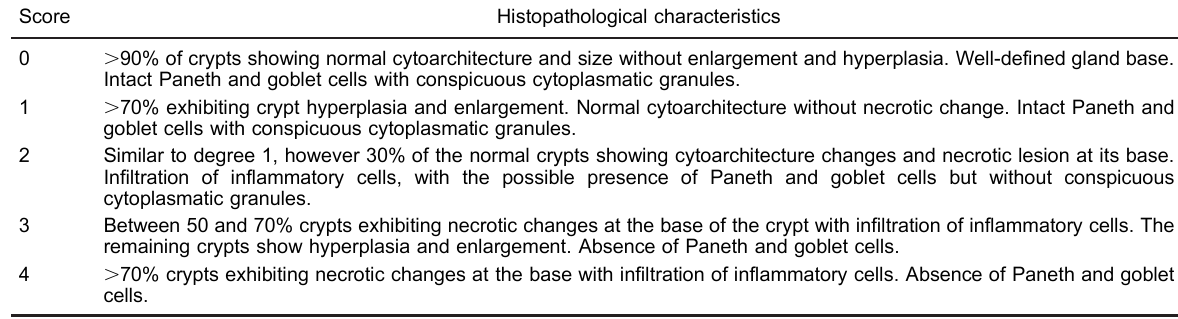
Table 1. Criteria used to determine intestinal crypt scoring of experimental mice challenged by 5-FU-induced mucositis. Score Histopathological characteristics